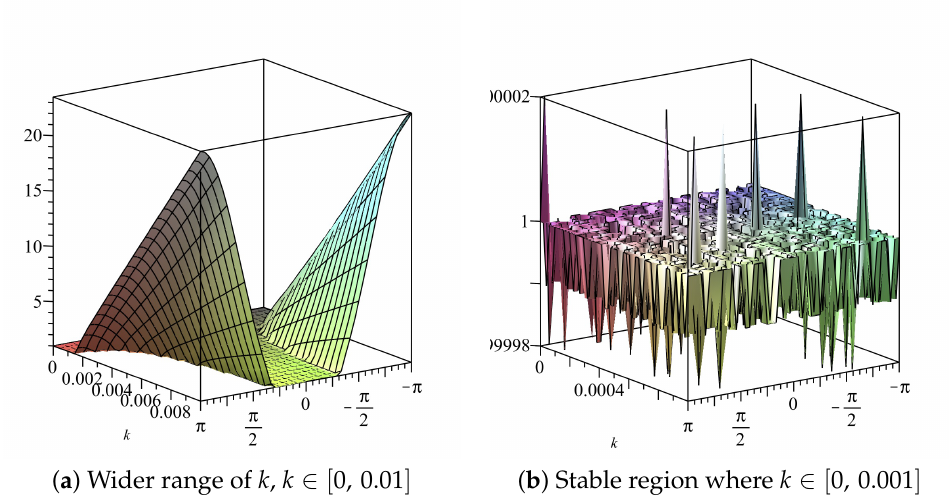
Figure 22. Plot of | ξ 2 | vs. k vs. w ∈ [ − π , π ] of Scheme 2 for Numerical Experiment 2. The spatial step size h = π